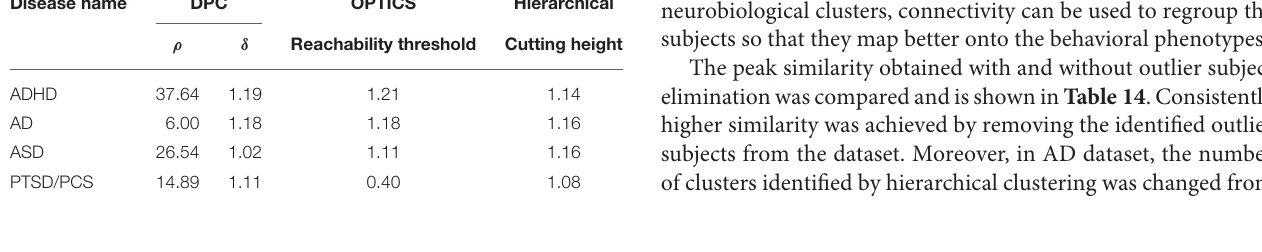
TABLE 6 | Estimated optimal values of each input parameter in clustering for phenotypic vs. connectivity comparison. Disease name